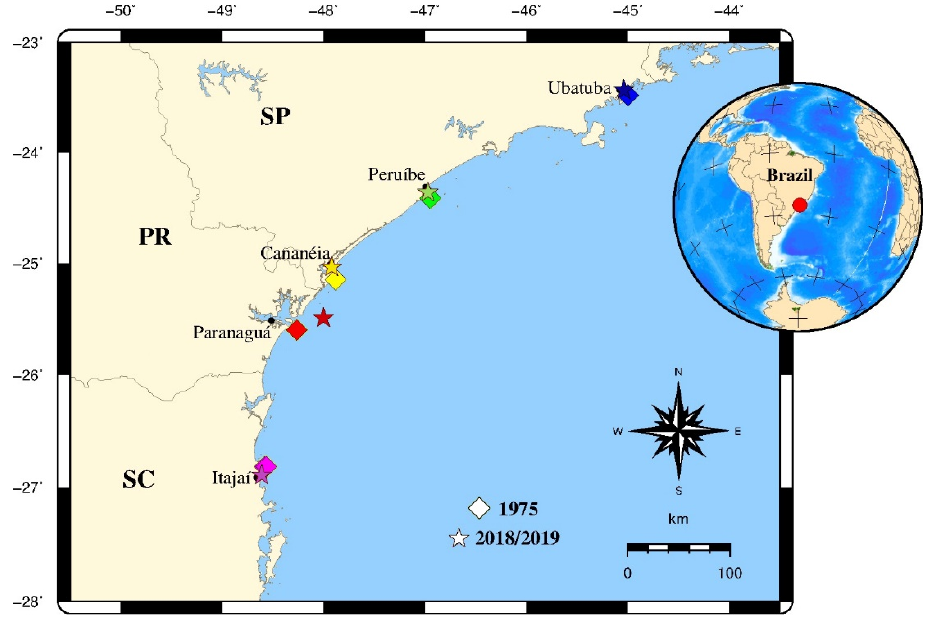
Figure 1. Sampling locations of Isopisthus parvipinnis juvenile individuals collected in 1975 (squares) and 2018/2019 (stars) in the South Brazil Bight from 23° S to 26.9° S, between São Paulo and Santa Catarina states. Legend: North of São Paulo (NSP), Center of São Paulo (CSP), South of São Paulo (SSP), Paraná (PR), Santa Catarina (SC).